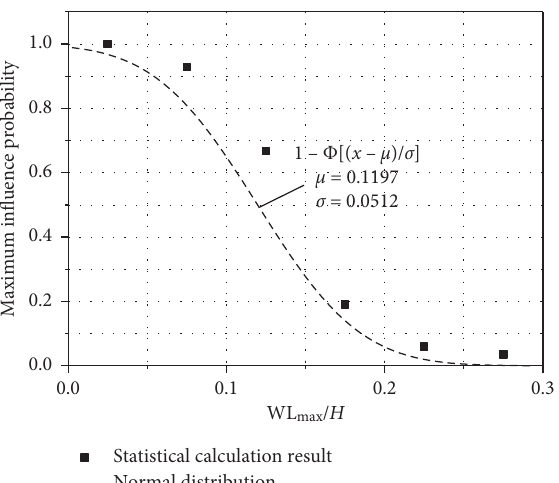
Figure 25: Fitting results of the maximum influence probability of the debris accumulation distribution along the X axis under the continuous collapse.